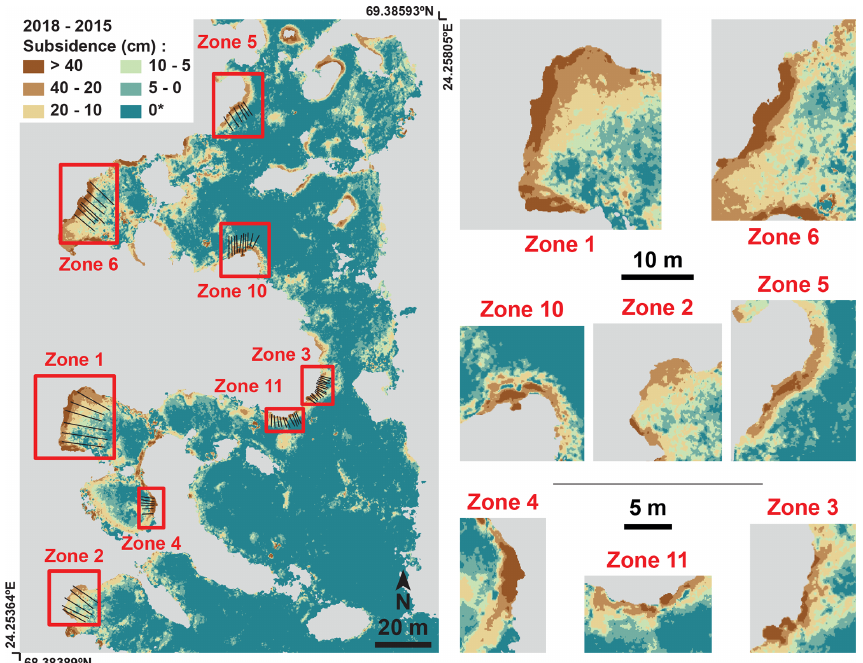
Figure 6. Left: subsidence over the Šuoššjávri peat plateau. The black lines indicate the profiles used to derive the edge retreat metric described in Sect. 3.2 (HvsV index). Note that the color scale is truncated for subsidence values higher than 40cm and lower than 0cm (which corresponds to an increase in surface elevation, generally due to vegetation change between the two years). Right: edge transect areas of the plateau used to compare observed and simulated lateral thermokarst patterns (Sect.